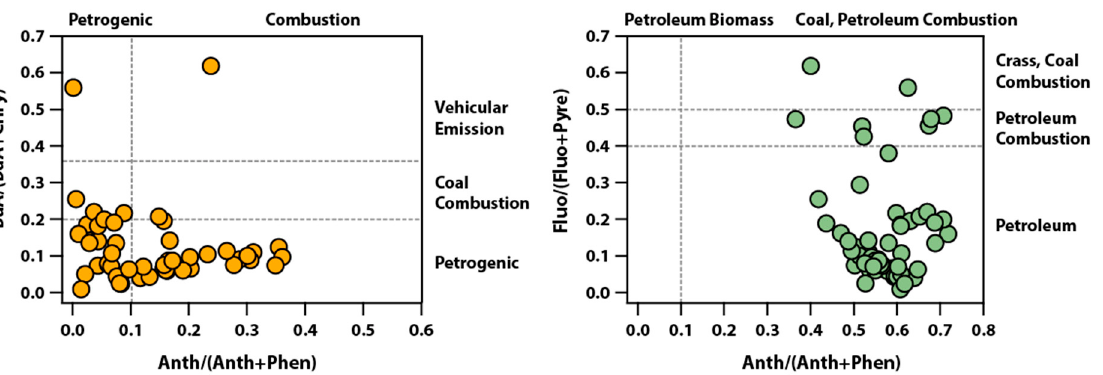
Figure 3. PAH cross-plots for the ratio of Anth/(Anth/Phen) vs. BaA/(BaA+Chry) and Anth/(Anth+Phen) vs. Fluo/(Fluo+Pyre).